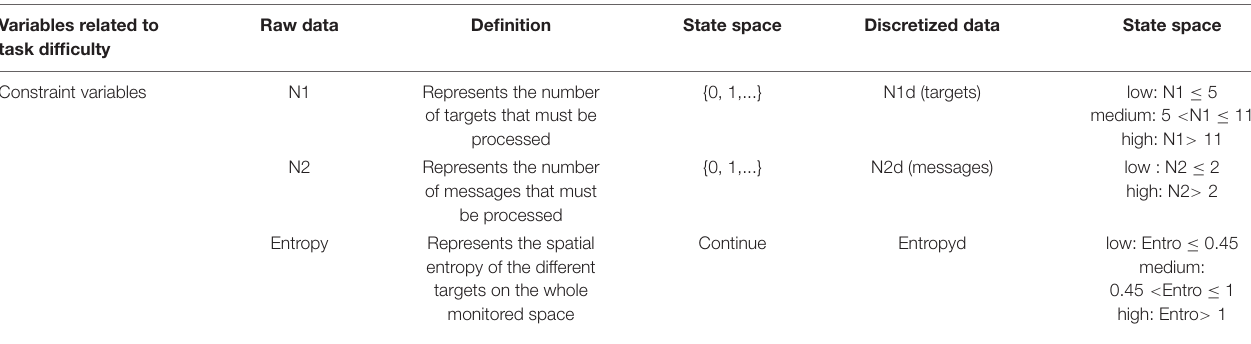
FIGURE 2 | Supervised learning of physiological data. TABLE 2 | Data processing for task difficulty